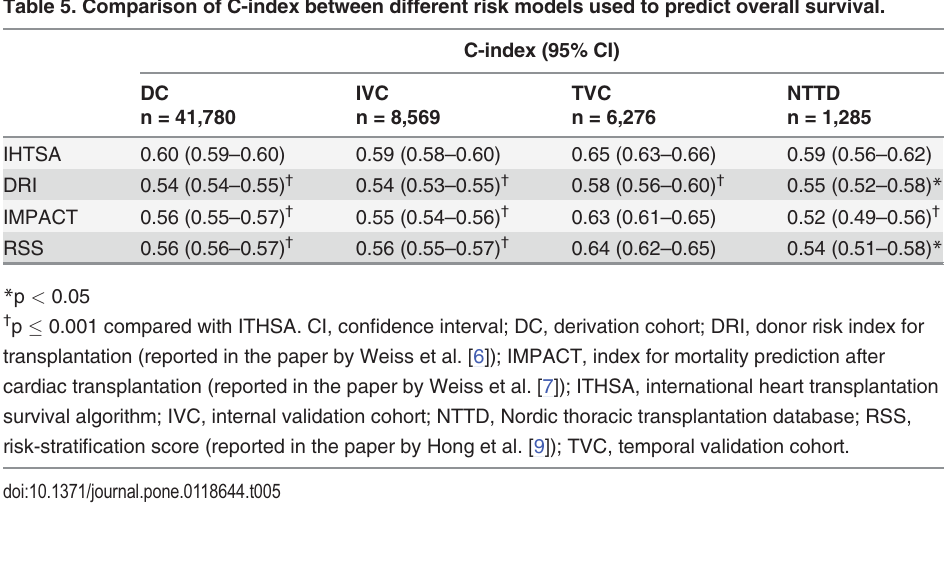
Table 5. Comparison of C-index between different risk models used to predict overall survival. C-index (95% CI) DC